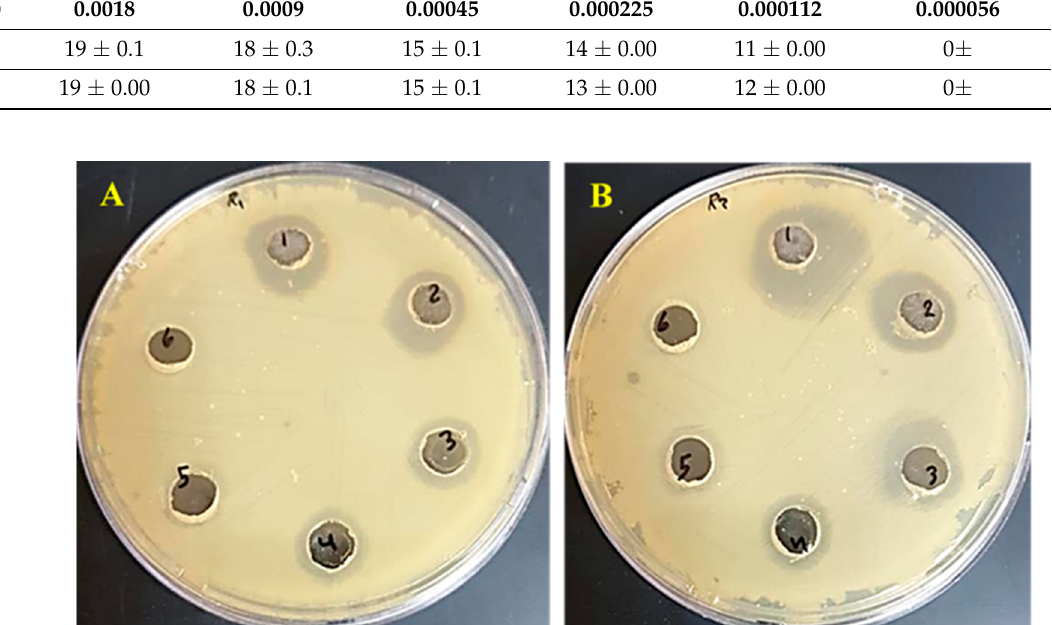
Table 6. Comparison study with other researches on antibacterial activity. Sources